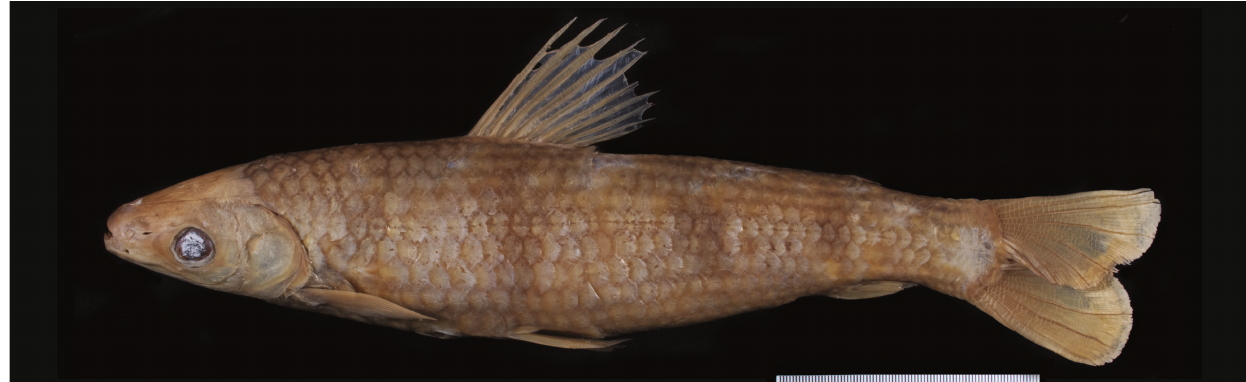
Fig. 2 . Schizodon dissimilis , MCZ 19383, Lectotype 264.6 mm SL, rio Poti, Piauí